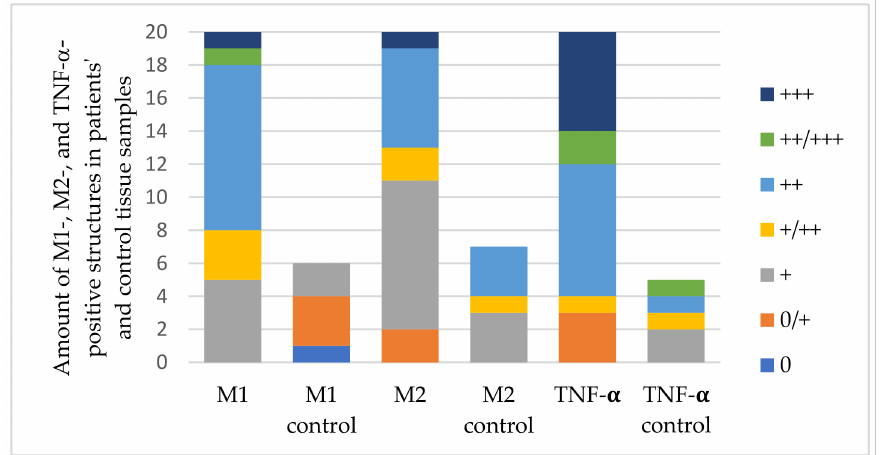
Figure 2. The distribution of M1-, M2-, and TNF- α -positive structures in patients’ group and